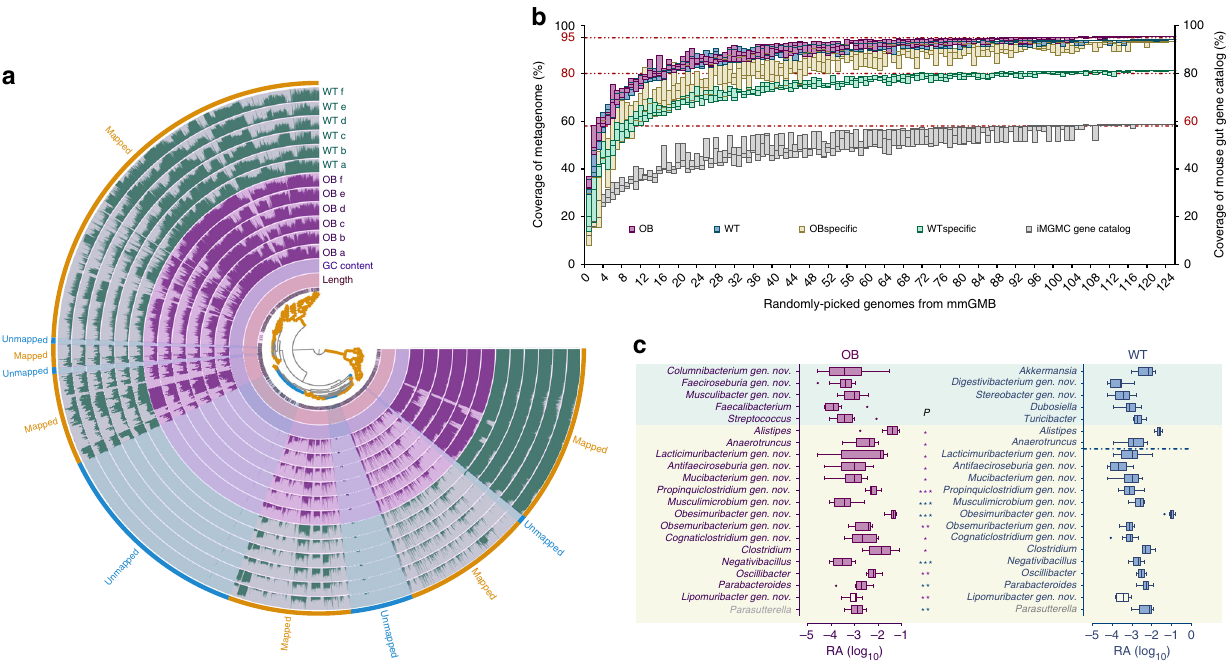
Fig. 4 The metagenomic functions covered by the mGMB and the GM features associated with mouse phenotypes. a The mapping pro fi le of metagenomic short reads of OB and WT to the mGMB pan-genome. OB: metagenomes of ob/ob mouse GMs ( n = 6); WT: metagenomes of C57BL/6J mouse GMs ( n = 6). The Anvi ’ o tree displays the hierarchical clustering of the mGMB pan-genome; WT layers a – f represent the detection of each split in WT; OB a – f represents the detection of each split in OB; the outermost yellow layer displays the splits in the pan-genome mapped by the metagenomic reads; the most outer blue layer displays the splits in the pan-genome unmapped to the metagenomic reads. b KO-based coverage of mouse gut microbiomes by genomes randomly picked from the mGMB. OB: the KEGG Ortholog (KO) pool of metagenomes of ob/ob mouse GMs ( n = 6); WT: the KO pool of metagenomes of C57BL/6J mouse GMs ( n = 6); OB-speci fi c: KOs appearing speci fi cally in OB; WT-speci fi c: KOs appearing speci fi cally in WT; iMGMC gene catalog: the integrated mouse gut metagenome catalog (iMGMC) comprising 4.6 million unique genes and 660 high-quality metagenome- assembled genomes 27 . Data are shown with box plot, center line: median, bounds of box: extreme. c The features of the gut microbiota at the genus level associated wild-type (C57BL/6J) and metabolic-syndrome ( ob/ob C57BL/6J) mice. OB: the 16S rRNA gene amplicons of ob/ob mouse cecal samples ( n = 12) used for previous bacterial isolation; WT: the 16S rRNA gene amplicons of the counterpart wild-type C57BL/6J mice ( n = 12). Data are shown in a box- and-whiskers plot, center line: median, bounds of box: quartile, whiskers: Tukey extreme; statistical comparisons of the data between the two groups used the t test, ∗ P < 0.05; ∗∗ P < 0.01; ∗∗∗ P < 0.001; purple: enriched in OB, blue: enriched in WT; mint-colored background: genera exclusively presenting in either the OB or WT groups; cream-colored background: genera presenting in both groups but with signi fi cant difference in RA; gray genus names: genera that were not recovered by the mGMB. The n numbers represent the biologically independent samples. P -values are provided as a Source Data fi